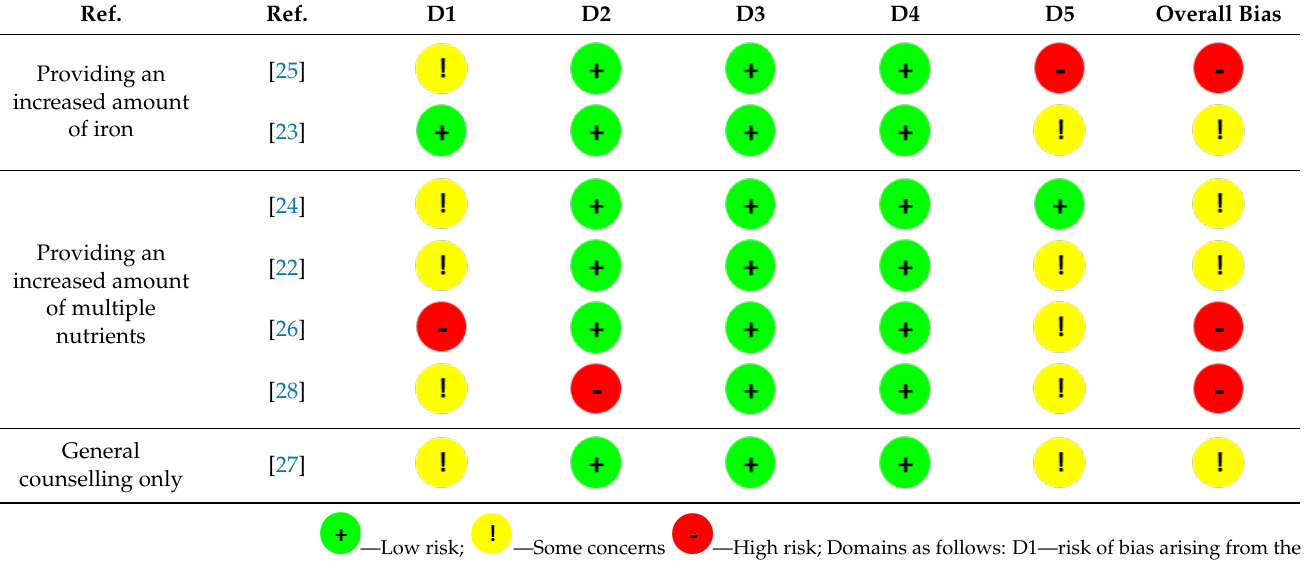
Table 8. The assessment of the risk of bias within the randomized controlled trials included in the systematic review conducted using the revised Cochrane risk of bias tool for randomized trials [22 – 28].